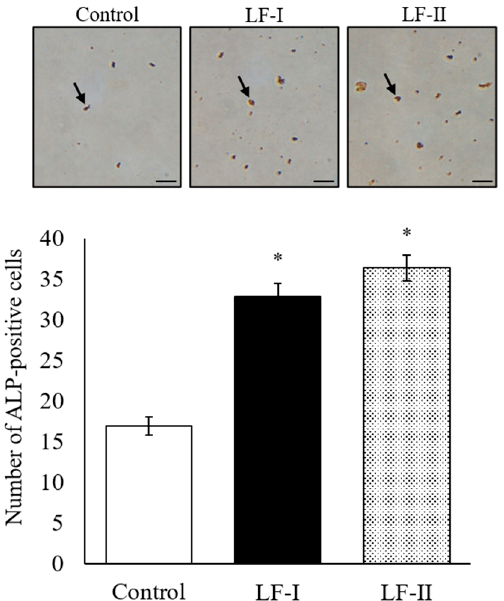
Figure 4. Number of ALP-positive cells after LF treatment with ascorbic acid (50 µ g/mL) and β -GP (10 mM) for 2 weeks. Arrows indicate ALP-positive cells, stained red. The number of ALP-positive cells was counted in four random fields per well. Bar = 100 µ m; data are presented as means ± SD of six samples in each group; * p < 0.05, compared with the control. LF, lactoferrin.